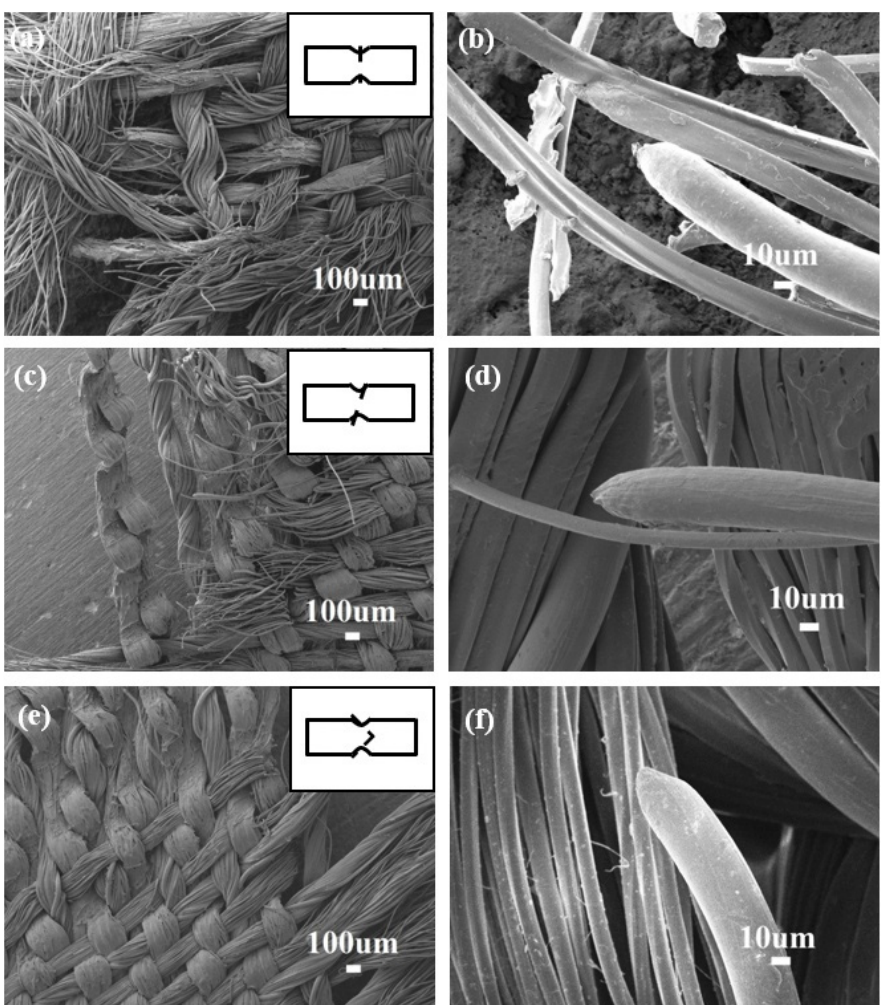
Figure 3. The SEM images of the fractured surface of ( a ) 0° specimen, ( c ) 90° specimen, and ( e ) 45° specimen with the insets showing the corresponding whole fractured surface schematically by the dashed lines. Lateral surface of the fractured MGFs for ( b ) 0° specimen, ( d ) 90° specimen, and ( f ) 45° specimen.